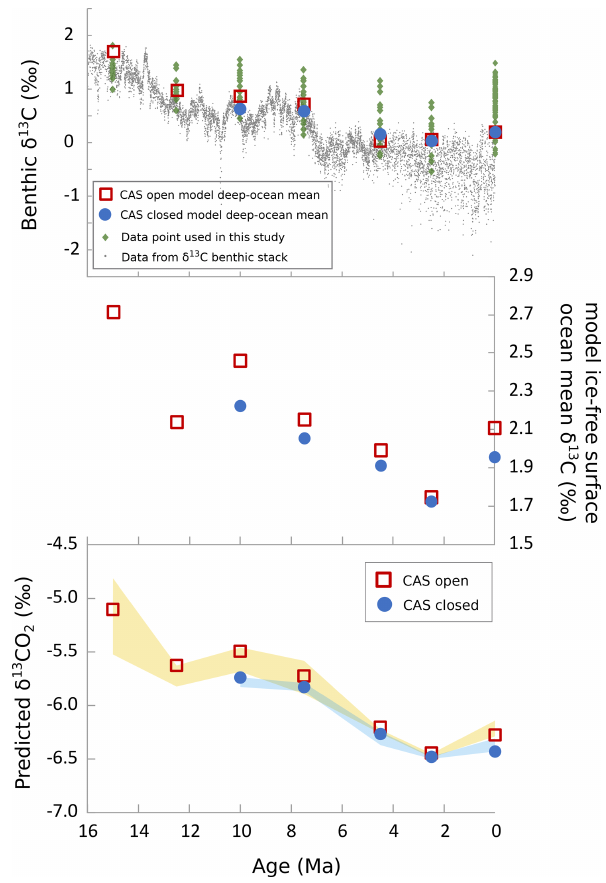
Figure 8. Inferred global benthic mean δ 13 C, global mean surface ocean δ 13 C, and atmospheric δ 13 CO 2 calculated using the mean bias of the best fit model to the data-indicated benthic ocean δ 13 C in each time slice. The data points from the δ 13 C benthic stack are from Westerhold et al. (2020). The shaded regions for predicted δ 13 CO 2 show the range of δ 13 CO 2 using the best ranges identified in Fig.